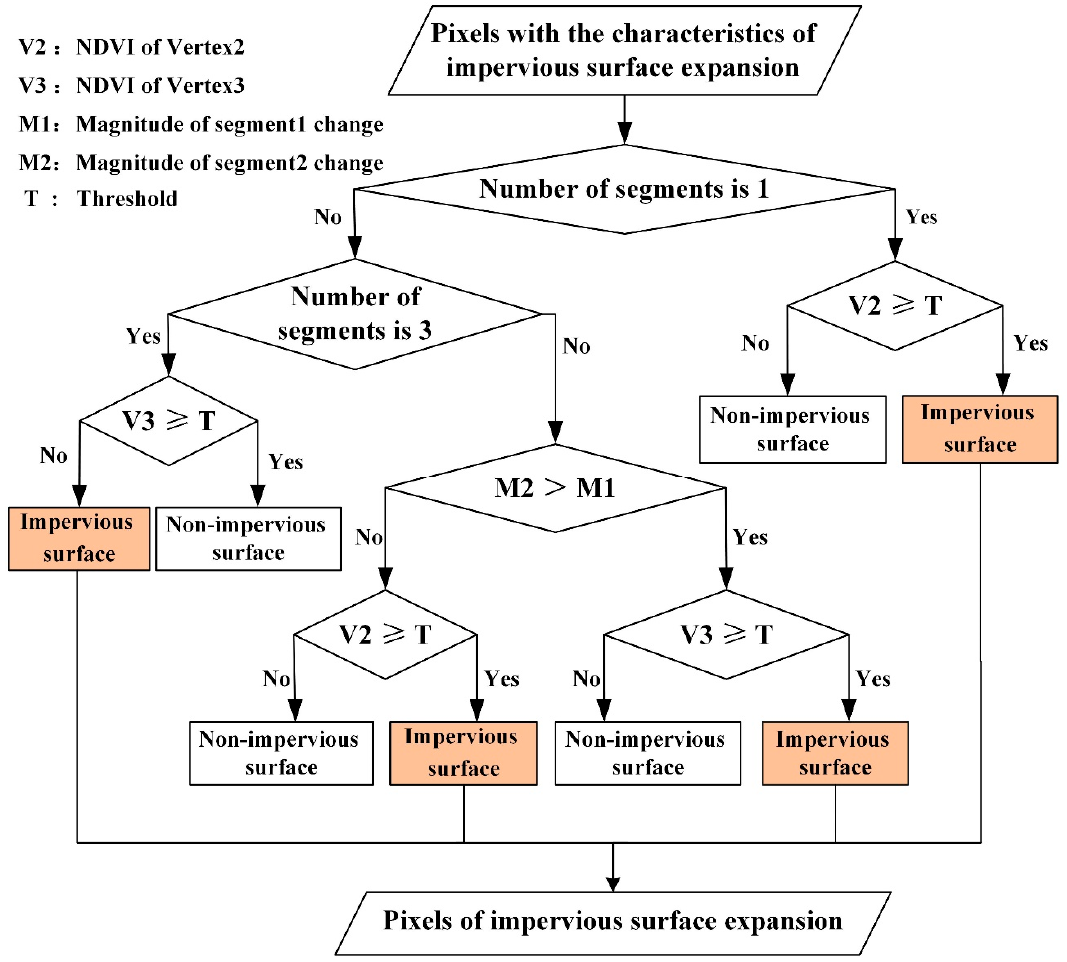
Figure 7. Decision tree for screening the impervious surface expansion pixels.